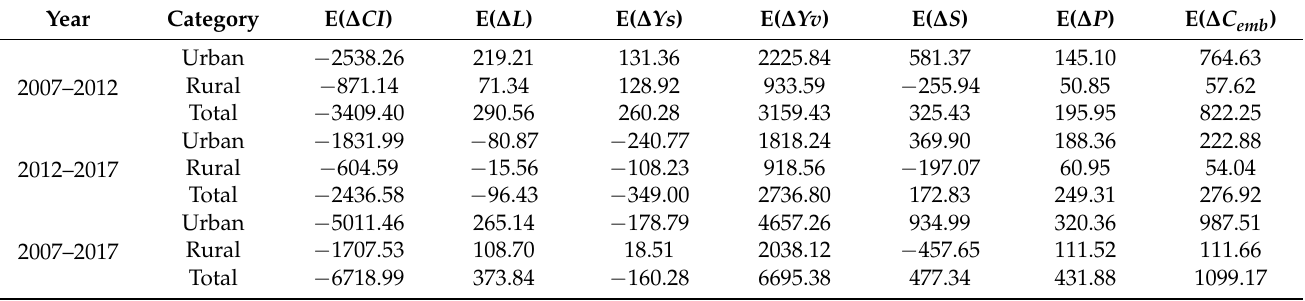
Table 1. Decomposition result of influencing factors of IHCEs in Fujian